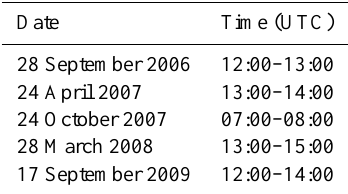
Table 1. Absolute calibration times of the HATPRO instrument at Payerne between 2006 and